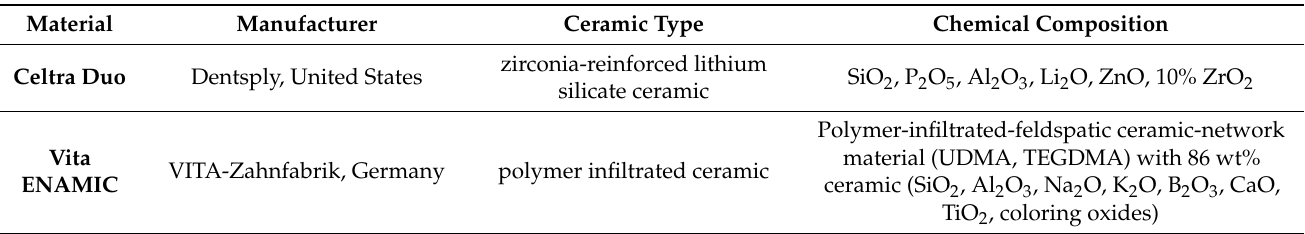
Table 1. The two tested materials’ composition (Celta Duo and Vita